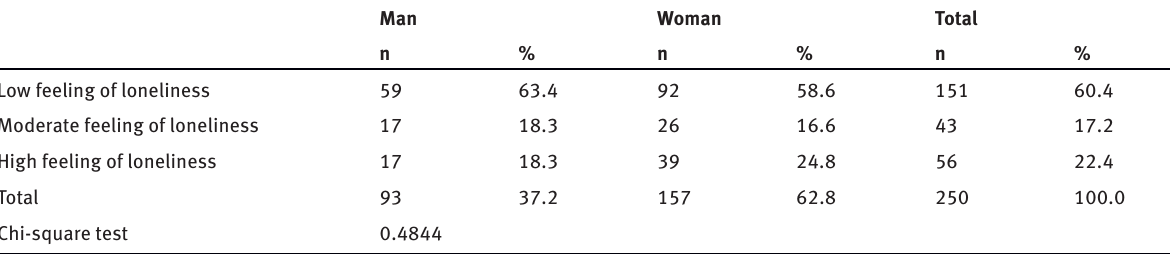
Table 2: DJG scale of loneliness depending on relations with family